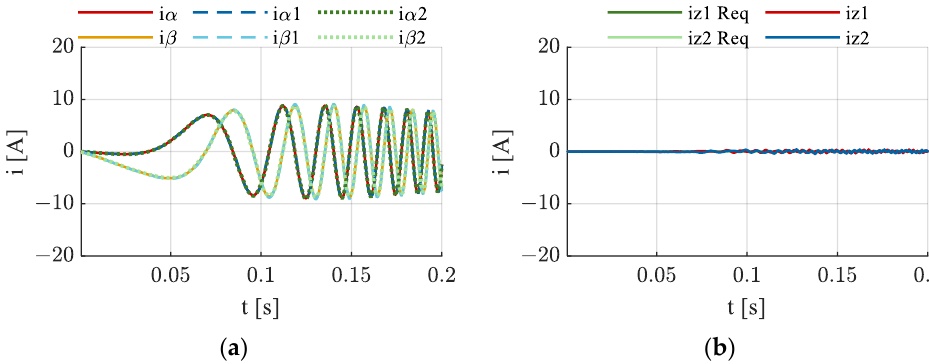
Figure 6. Current in transformed subsystems during the startup transient of the six-phase operation: ( a ) α–β subsystems; ( b ) z1 – z2 subsystem.